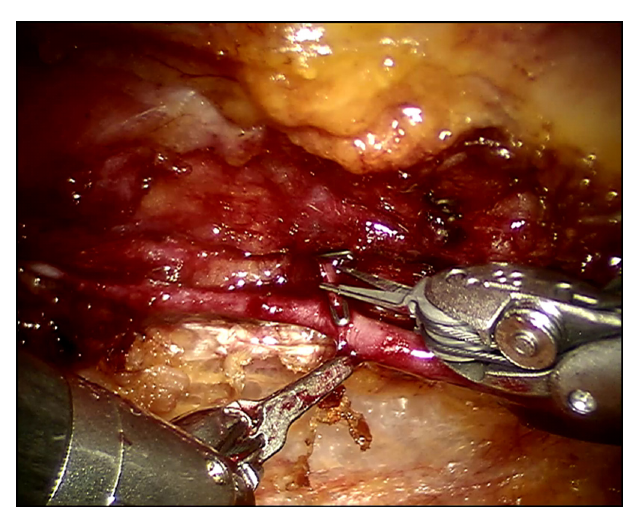
Fig. 3 – Use of endoscopic Potts scissors to cut